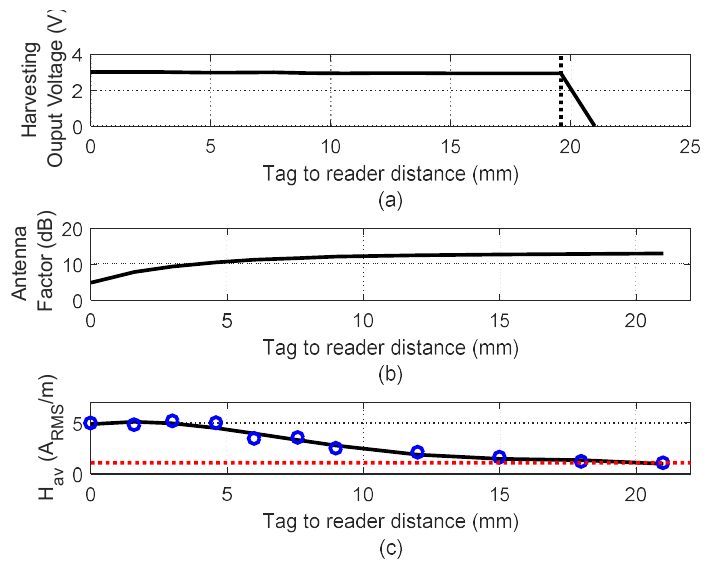
Figure 4. ( a ) Voltage of the harvesting NFC IC output in (V) as a function of the distance to the mobile reader; ( b ) Measured antenna factor as a function of distance to the mobile reader; ( c ) Measured magnetic field in A RMS /m as a function of the distance to the mobile reader.